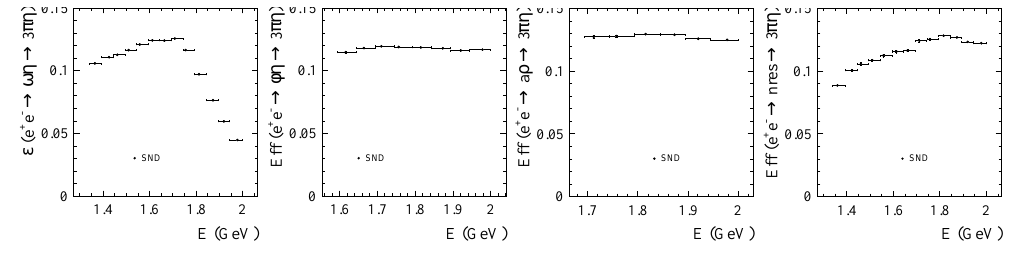
Figure 4. The detection e ffi ciencies for the four studied